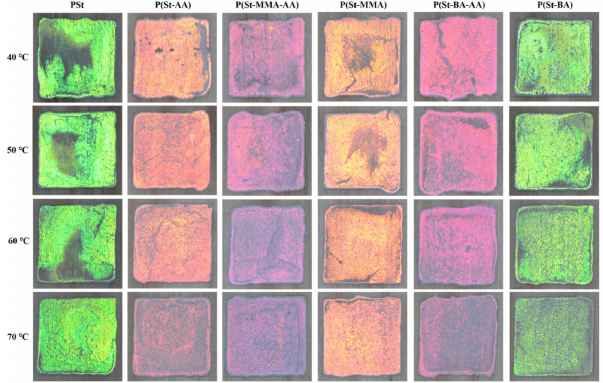
Figure 7. Images of as-prepared coatings of PSt-based colloidal microspheres on a wood surface, under white light